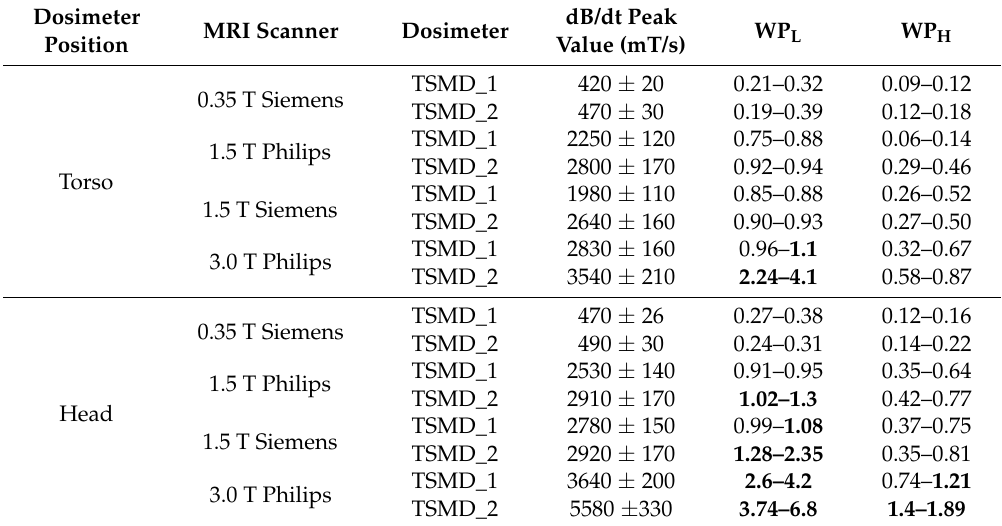
Table 5. dB/dt peak values and WP L and WP H indexes refer to emergency simulations. Bold values indicate noncompliance with regulatory limits.